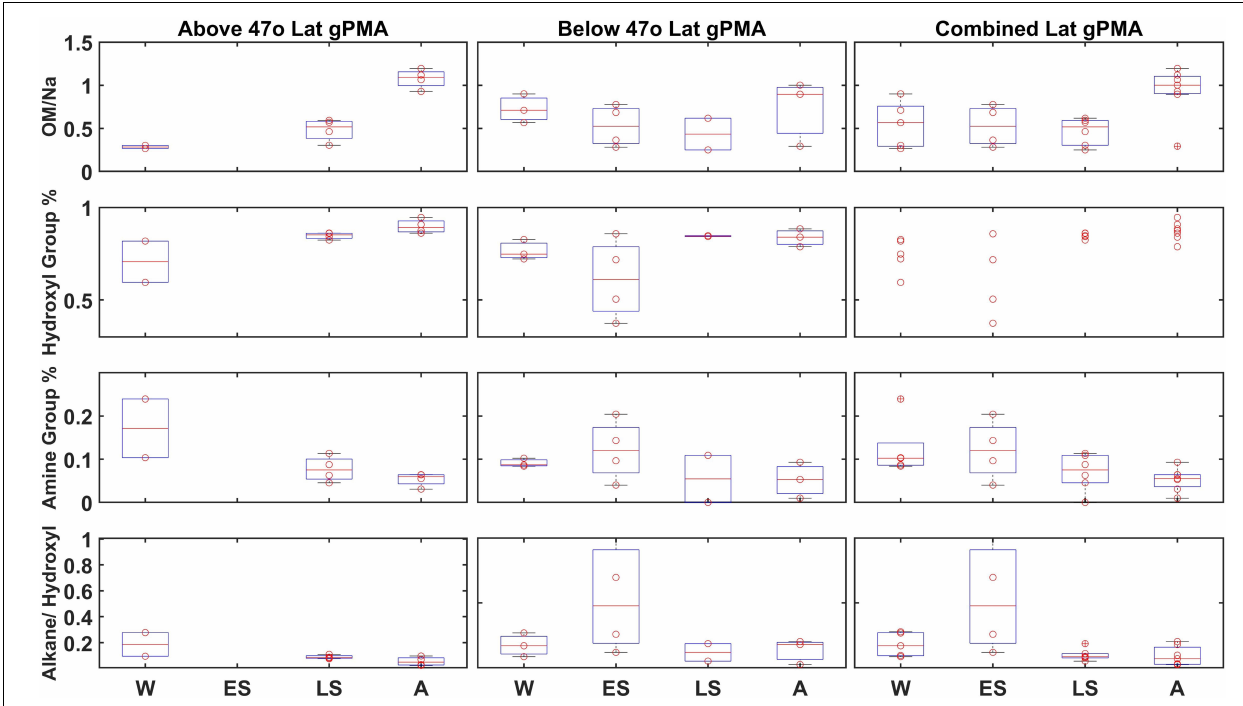
FIGURE 4 | Less than 1 µ m gPMA OM, normalized by Na, hydroxyl group percentage, amine group percentage, and alkane group percentage divided by hydroxyl group percentage (top to bottom) from each campaign (W, Winter; ES, Early Spring; LS, Late Spring; and A, Autumn): above 47 ◦ N, 47 ◦ N or below, and with no latitudinal separation (left to right). There were no filters above 47 ◦ N for Early Spring. The data are presented as box-whisker plots. The solid red line is the median and boxes cover the 25–75% percentile in the data. Red circle datapoints (individual measurements) are shown on top of box